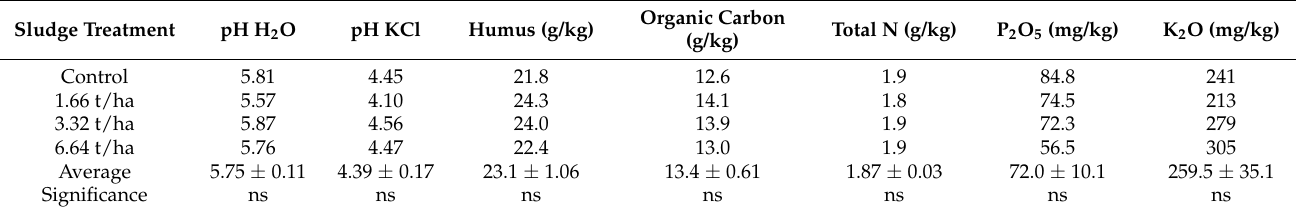
Table 1. Chemical properties of soils amended with municipal sewage sludge in single application rates and cultivated with Miscanthus.